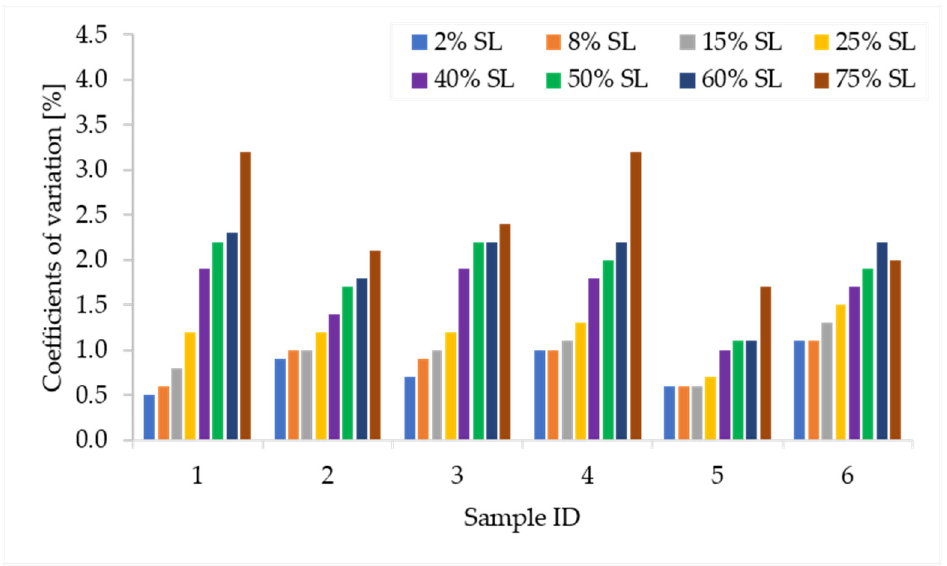
Figure 6. Coefficients of variation of fibrogram length values among tests at each percent span length during the long-term study.